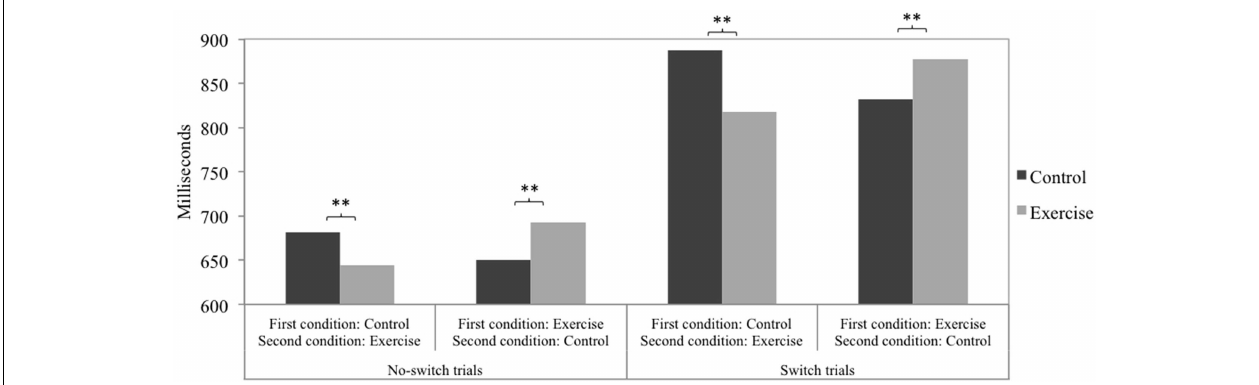
FIGURE 1 | The interaction of physical exercise (control, exercise) and order of conditions (control-exercise, exercise-control) on the speed measures of no-switch trials and switch trials. Post-hoc tests were Bonferroni corrected. ** p < 0 . 01 .